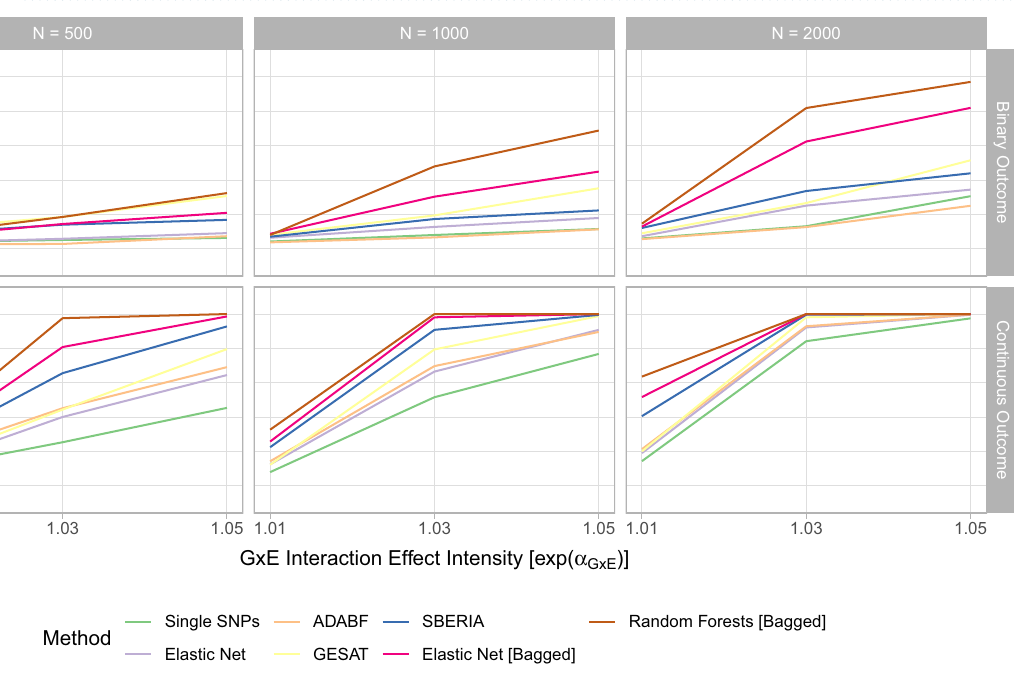
Figure 3. Type I error rates of the single SNP test, the GRS-based test using elastic net, ADABF, GESAT, SBERIA, the bagged GRS-based test using elastic net, and the random-forests-based test for testing GxE interactions in the simulation study.